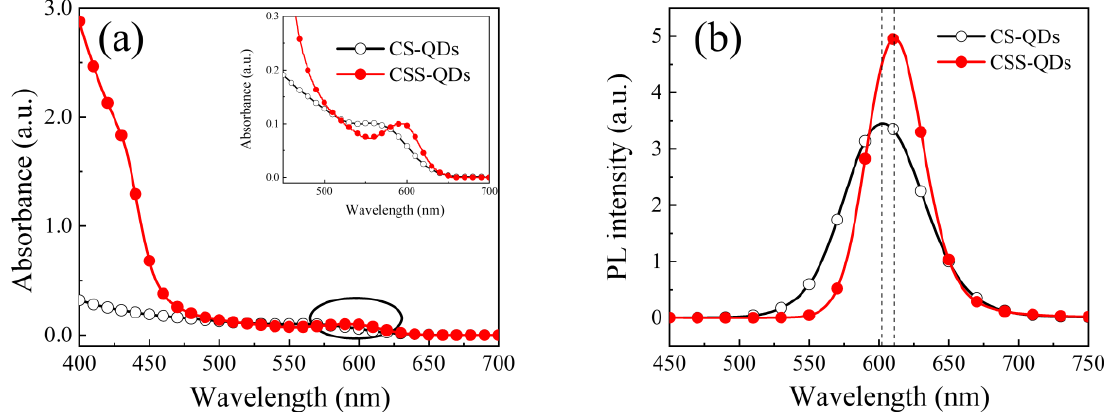
Figure 2. ( a ) UV-vis absorption spectra of both CS − QDs and CSS − QDs. The inset shows the details of band-edge absorption peaks of CS − QDs and CSS − QDs. ( b ) PL spectra of both CS − QDs and CSS − QDs.